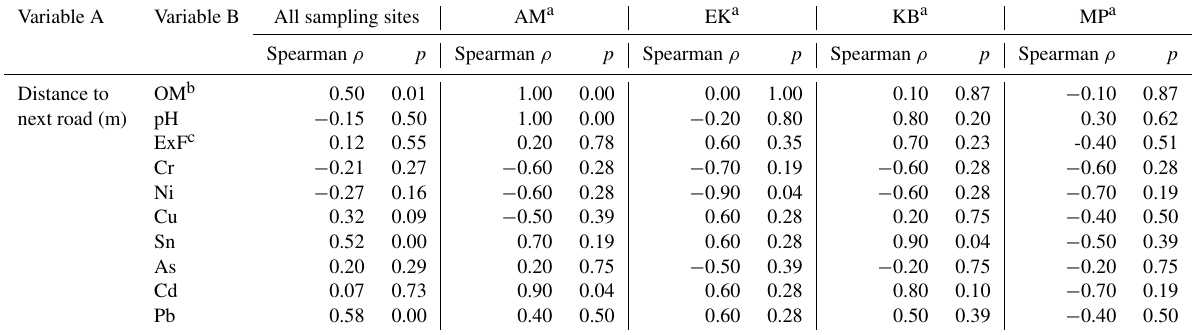
Table 3. Spearman correlation between distance to next road, exposure factor (ExF) and metal concentrations. Variable A Variable B All sampling sites AM a